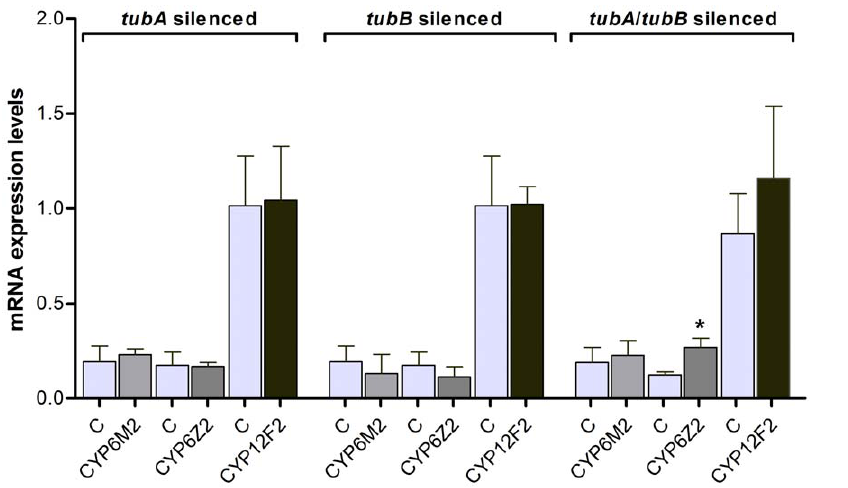
Figure 4. Effect of silencing tubA or tubB (or co-silencing tubA and tubB ) on P450 cytochromes mRNA expression levels in midguts. Midguts were collected 24 hours after a P. berghei infected blood meal. Data are shown as mean 6 SEM. *indicates significant differences ( p , 0.05) by Mann-Whitney test one-tailed.